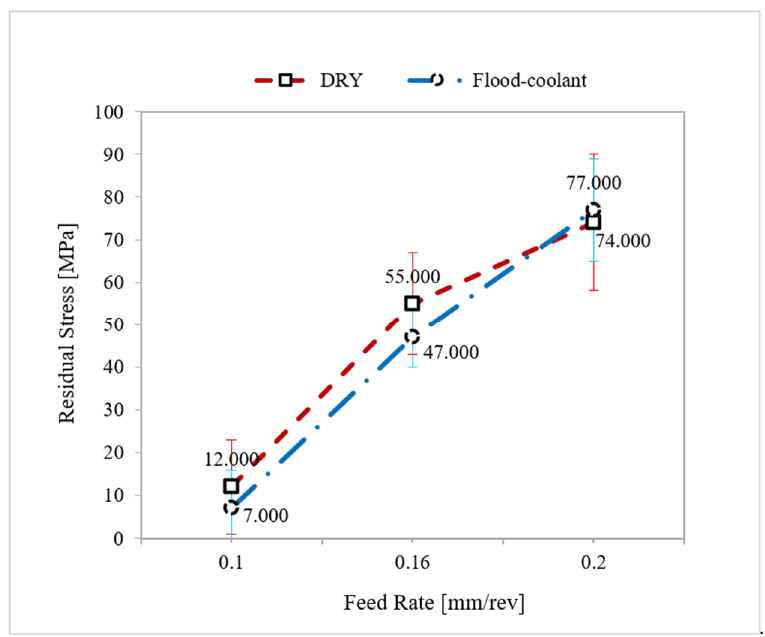
Figure 9. Variation of residual stresses with feed rate in dry and flood-coolant modes.